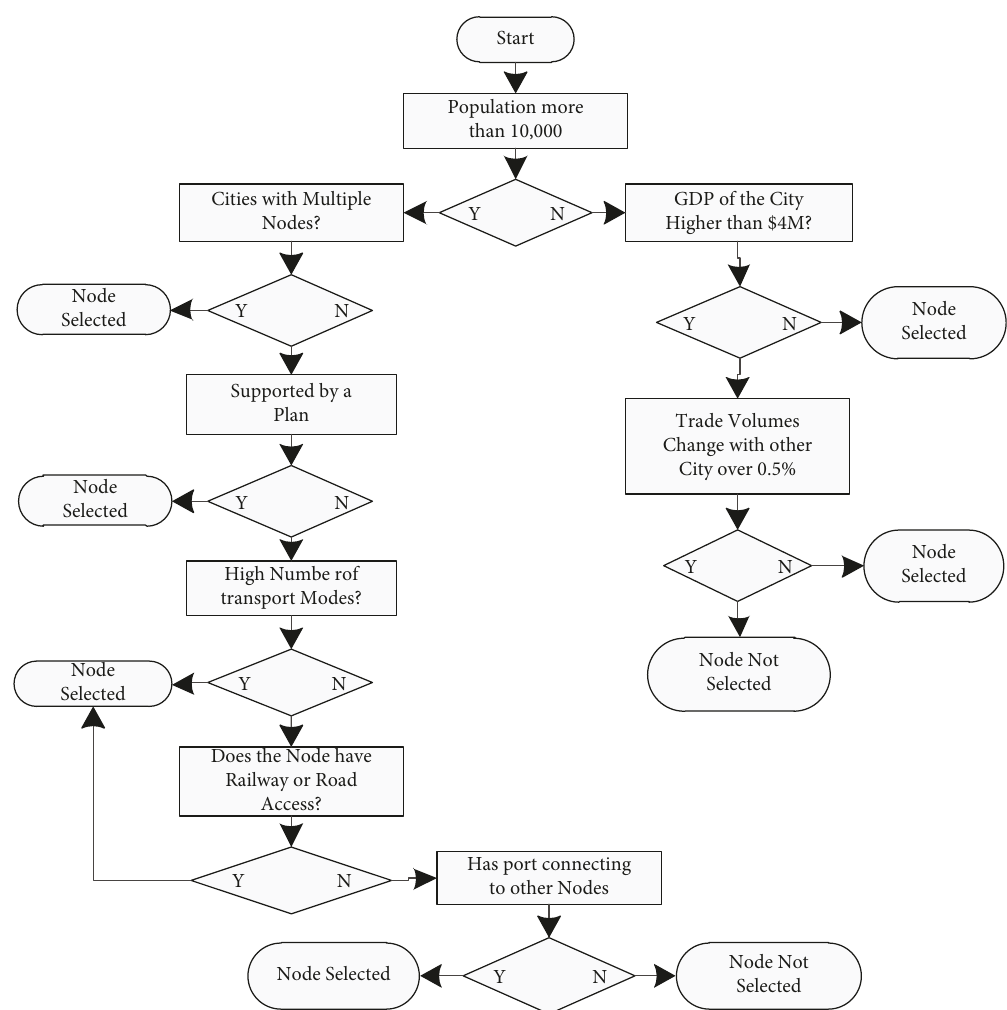
Figure 2: Objective selection of suitable origin nodes within